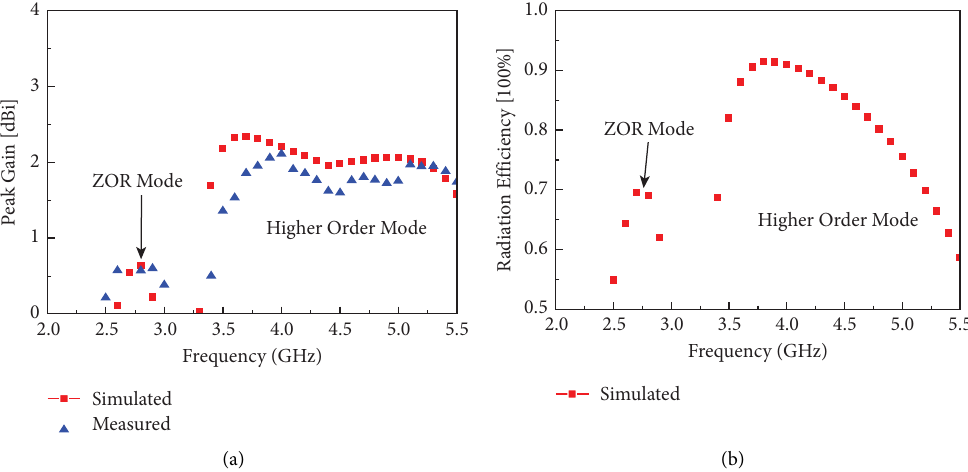
Figure 10: Far-feld results of proposed dual-band MTM antenna in the broadside direction. (a) Simulated and measured gain; (b) radiation efciency. Table 1: Comparison of dual-band MTM antennas with recently published work.